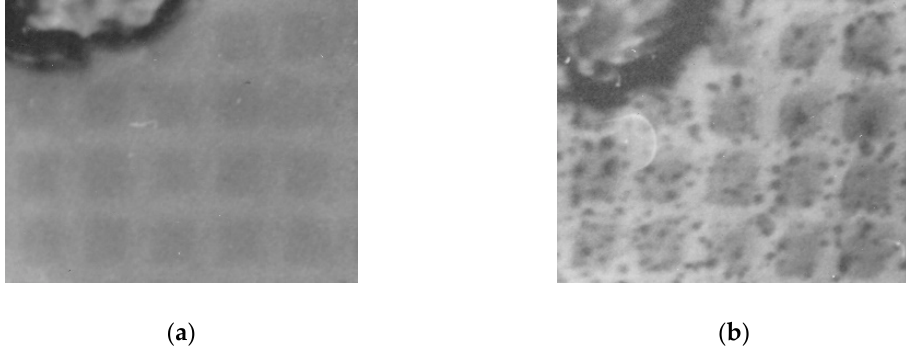
Figure 7. Optical microscopy image of the as-ion-implanted (Ar + , 3 × 10 15 cm − 2 , 80 keV) the C-face (000 1 (cid:3364) ) oriented 15R-SiC: ( a ) as-implanted 15R-SiC (dark grey squares are amorphized by ion implantation SiC), ( b ) 15R-SiC after epitaxial growth (dark grey squares are 3C-SiC). The dimensions of the dark grey areas are 50 × 50 µm 2 . On the upper right corner, a macroscopic defect is evident to show that the images are taken from nearly the same area. Dark grey spots in (b) stem from Si hillocks.